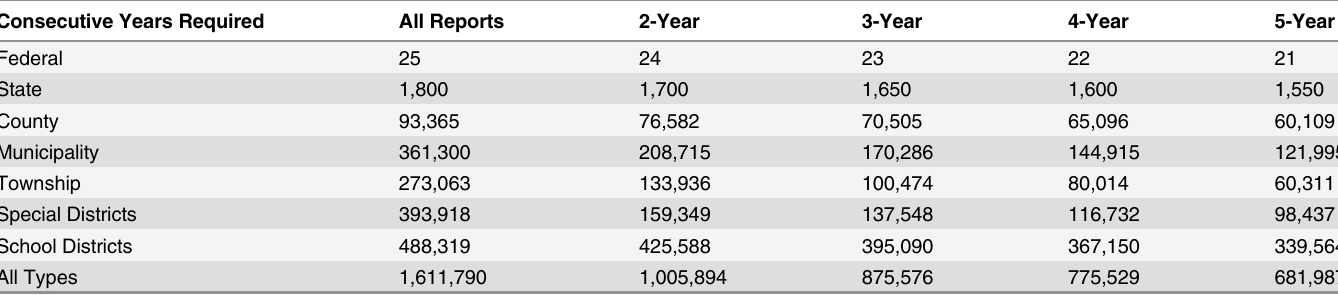
Table 10. The Impact of Requiring Consecutive Data on Sample